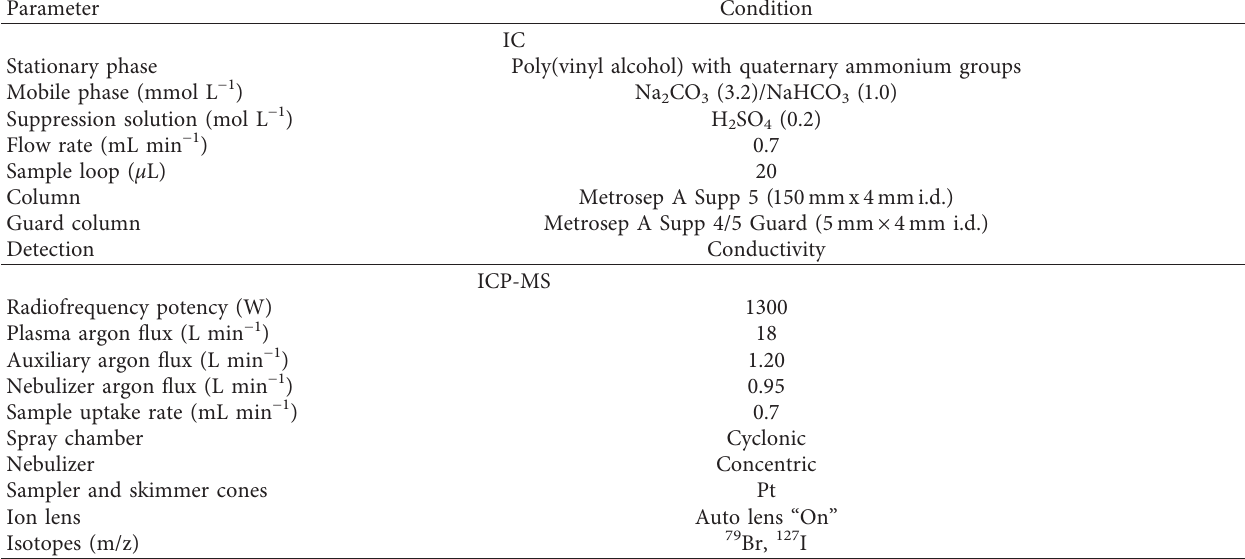
Table 1: Operational conditions for halogen determination by IC and by